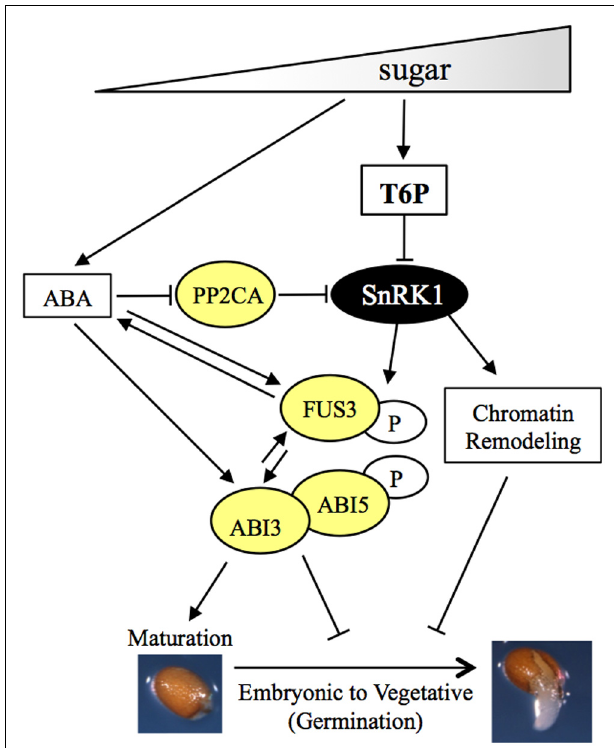
FIGURE 2 | Regulation of seed maturation and germination by sugars throughT6P and SnRK1. Model showing regulation of seed maturation and germination by sugars throughT6P and SnRK1. Sugars promote the transition from pattern formation to maturation through activation ofT6P and ABA synthesis and signaling pathways. An increase in ABA level during mid-embryogenesis, partly through the B3 domain FUS3, positively regulates SnRK1 by PP2C inactivation.T6P inhibits SnRK1 in vitro possibly to reset SnRK1 activity after ABA levels decline. SnRK1 modulates the activity or expression of B3-domain (FUS3, ABI3) and bZIP (ABI5) transcription factors through direct phosphorylation or transcriptional regulation to induce seed maturation and inhibit germination. ABA in turn positively regulates FUS3, ABI3, and ABI5 through transcriptional and/or post-translational regulation. SnRK1 regulates seed germination also through chromatin remodeling (see text for